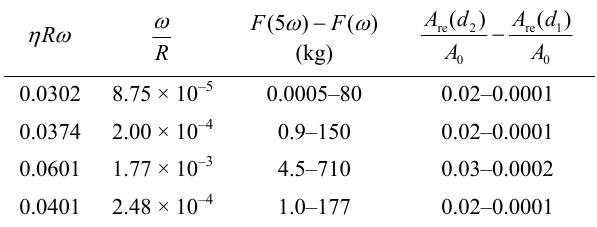
Table 1 The total load and real area of contact for concrete with Gumbel summits’ distribution in  and 5  .